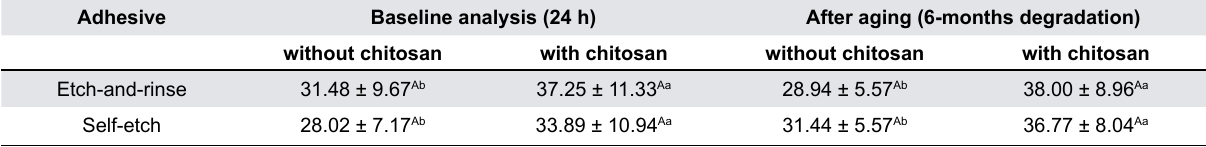
Table 1- The µTBS mean values (MPa) and standard deviations of the experimental groups